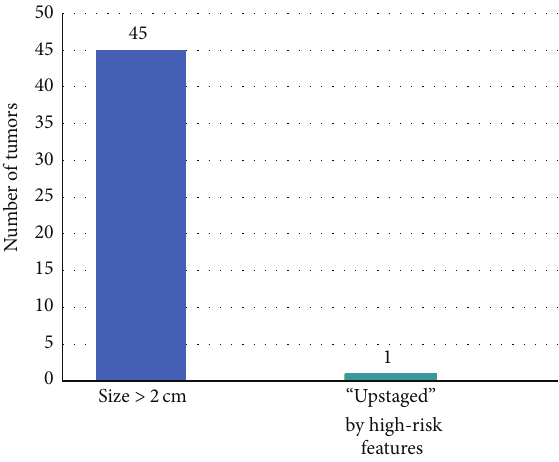
Figure 1: Proportions of Stage 1 versus Stage 2 tumors by AJCC criteria.